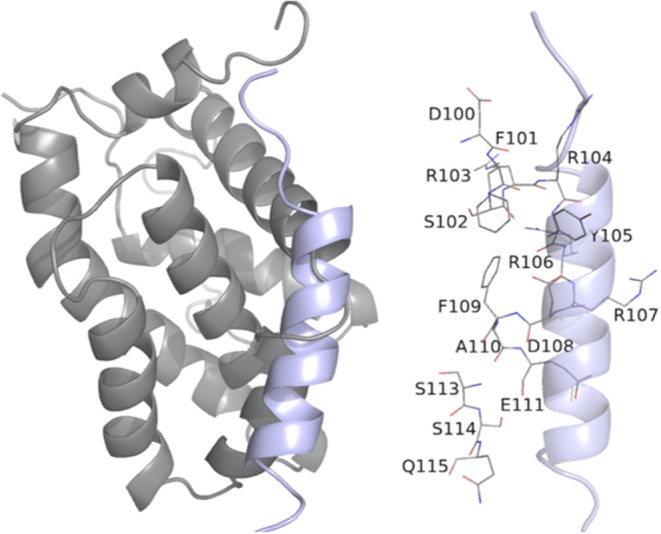
Representation of BCL-2 protein residues with BH3 peptide obtained from molecular docking performed in the GalaxyPepDock server with additional interactions, confirmed by BINANA 1.2.0.